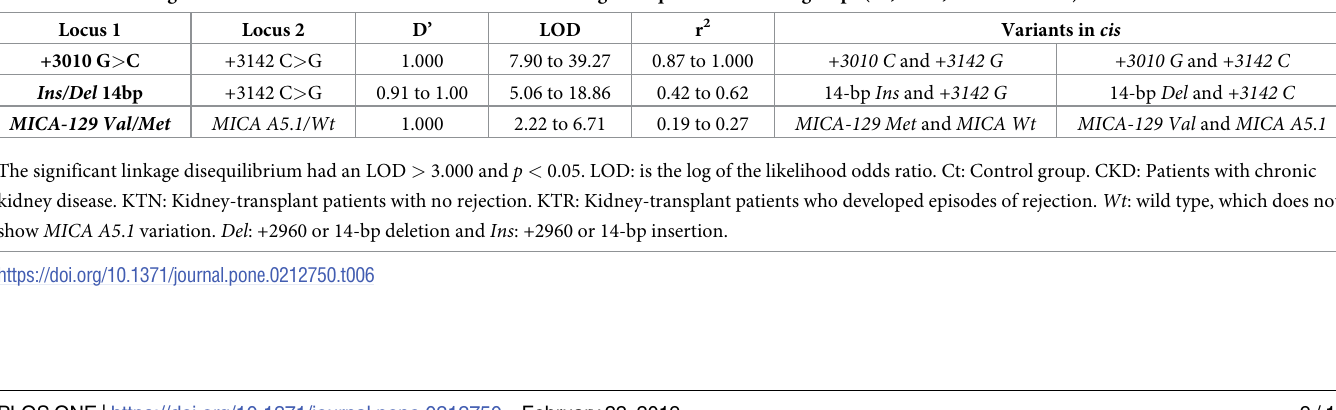
Table 6. The most significant results for HLA-G 3’-UTR and MICA linkage disequilibrium for all groups (Ct, CKD, KTN and